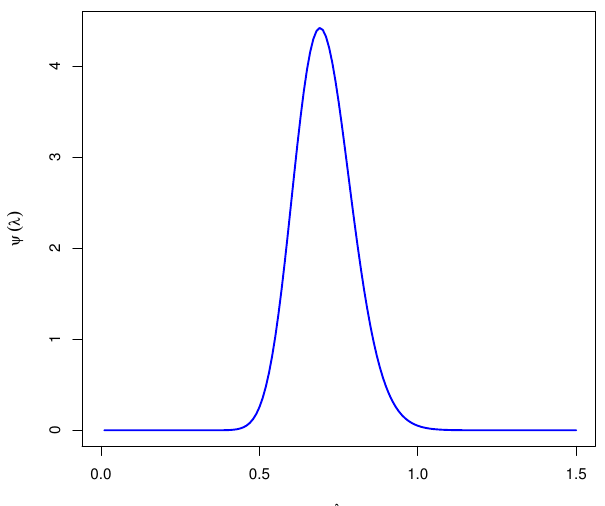
Figure 1. The full conditional distributions of λ